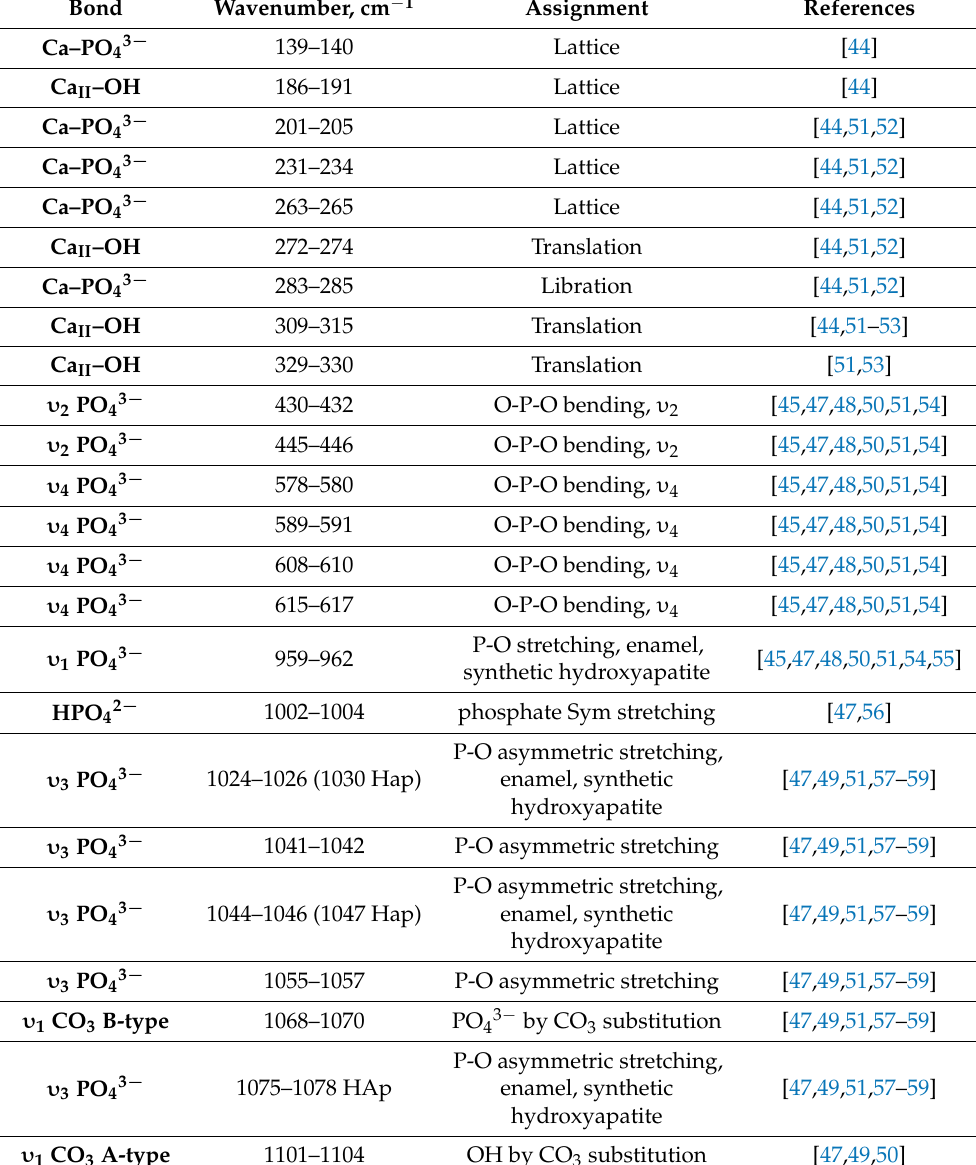
Table 1. Active Raman scattering modes in the spectra of the biomimetic and natural mineralized tissue (enamel), reference samples, and involved